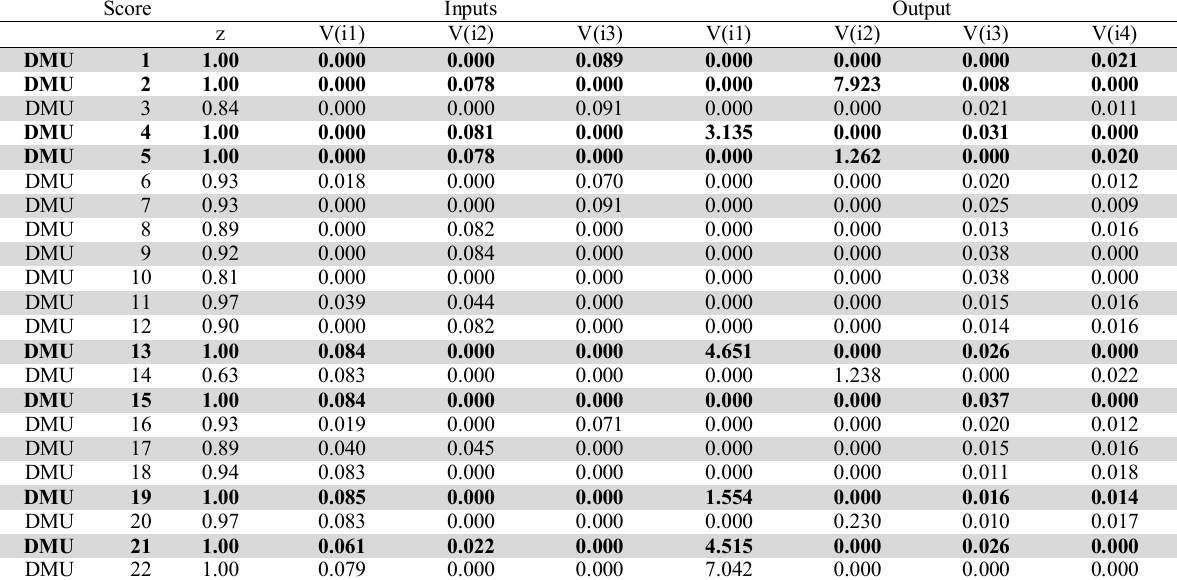
The results of DEA